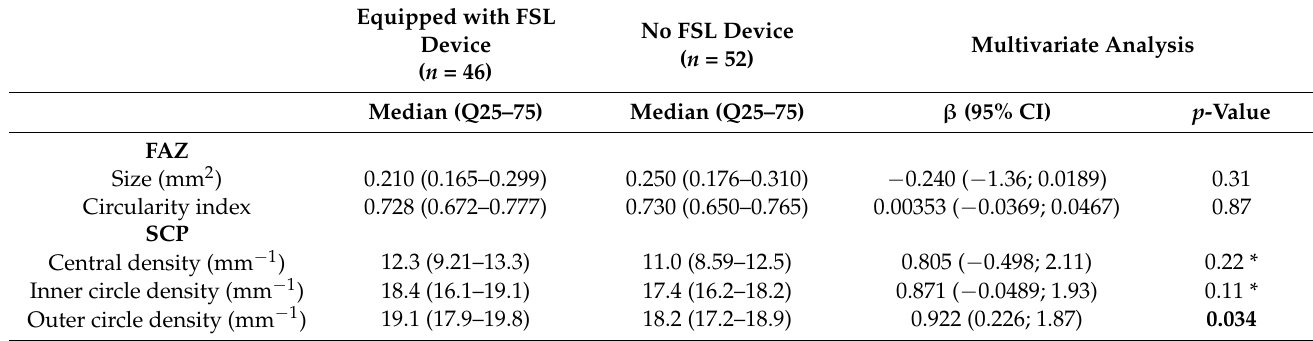
Table 4. Association between retinal vascular parameters and the use of an FSL